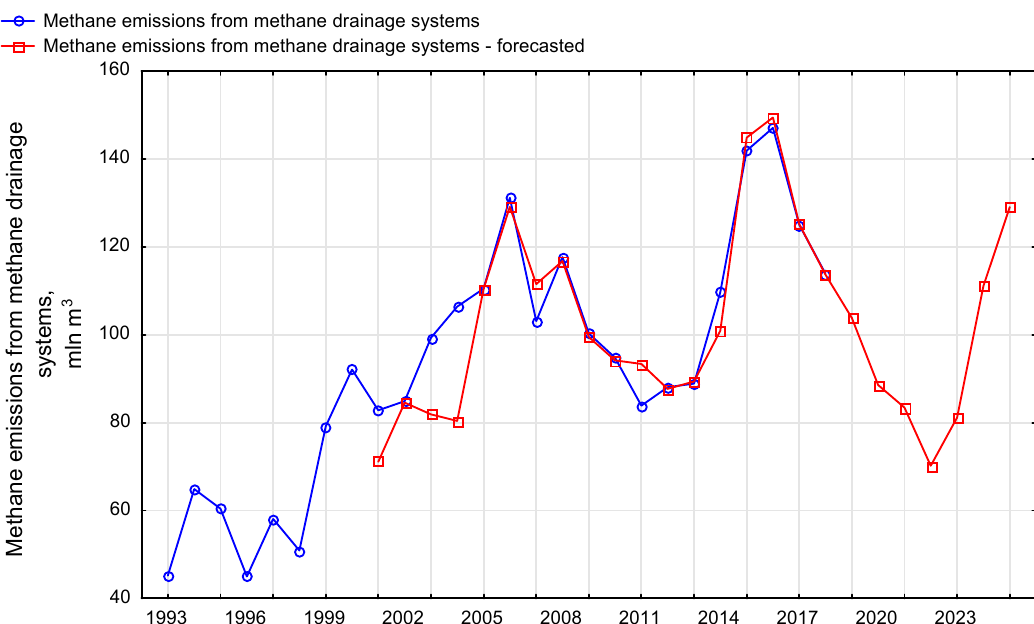
Figure 15. Actual and predicted amount of methane emissions from methane drainage systems into the atmosphere.